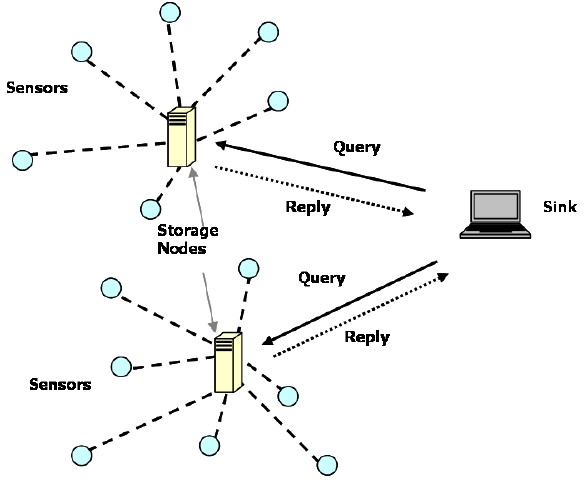
Figure 9. Two-tiered network model in Sheng and Li’s